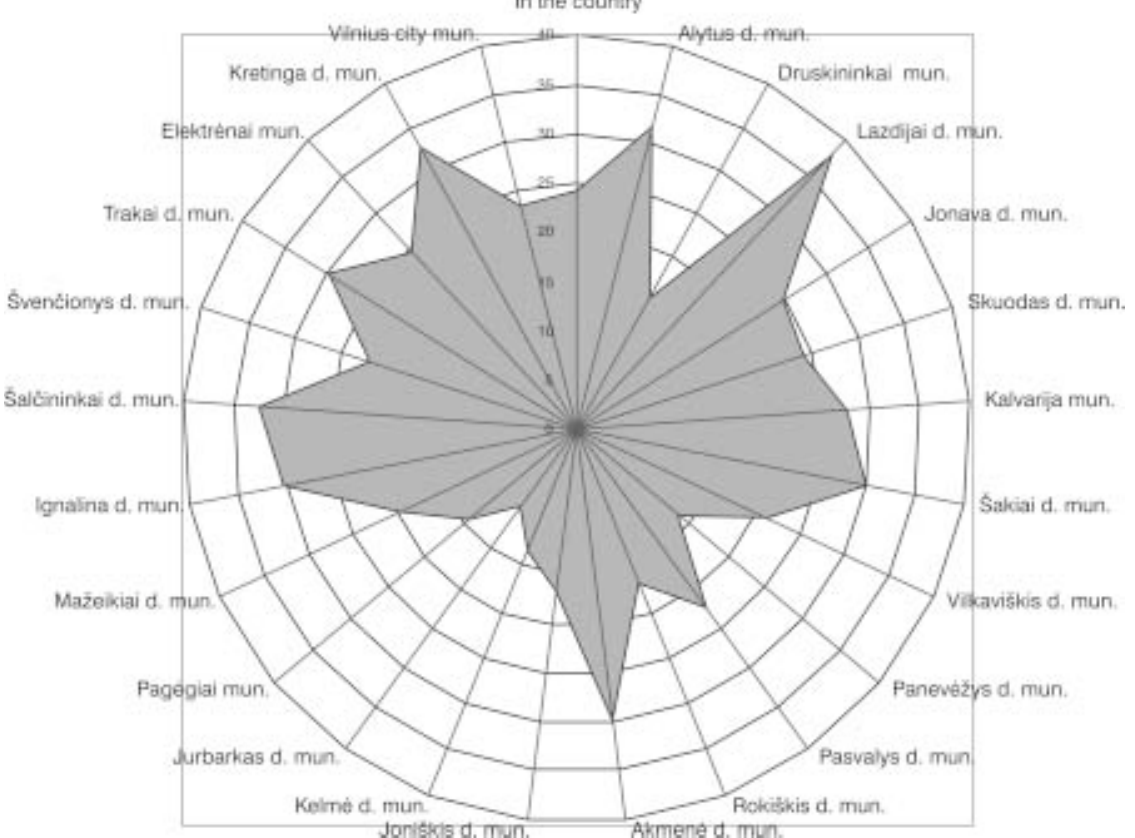
Fig 4. Portion of employable population not participating in the labour market in